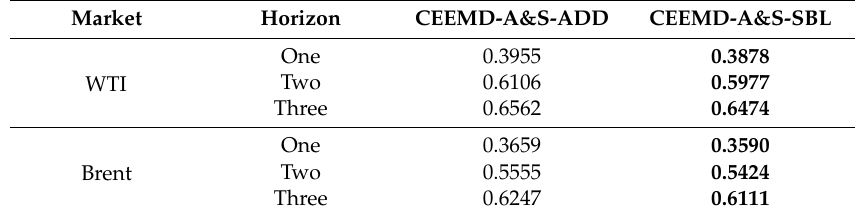
Table 13. The RMSE values of different prediction models on WTI and Brent crude oil prices.